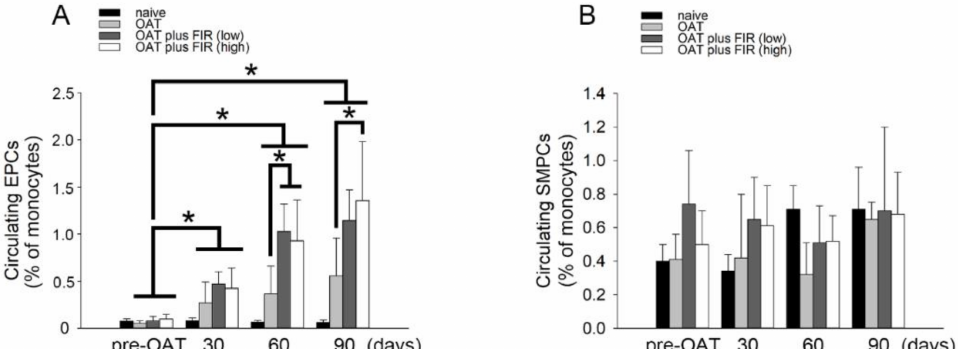
Figure 4. FIR therapy promotes EPCs mobilization in OAT-recipient ACI/NKyo rats. ( A ) CD133 + / VEGF + /CD34 + cells (defined as EPCs) mobilization at day 30–90 following OAT in ACI/NKyo rats were analyzed by flow cytometry. ( B ) CD133 + / α SMA + /CD34 − cells (defined as SMPCs) mobilization at day 30–90 following OAT in ACI/NKyo rats were studied. Quantification of EPCs (left) and SMPCs (right) in OAT-recipient rats (black bar, naive rats; light gray bar, OAT only rats; dark gray bar, OAT rats with low intensity of FIR therapy; white bar, OAT rats with high intensity of FIR therapy). All results are expressed as the mean ± SD ( n = 5). * p < 0.05 was taken into consideration statistically